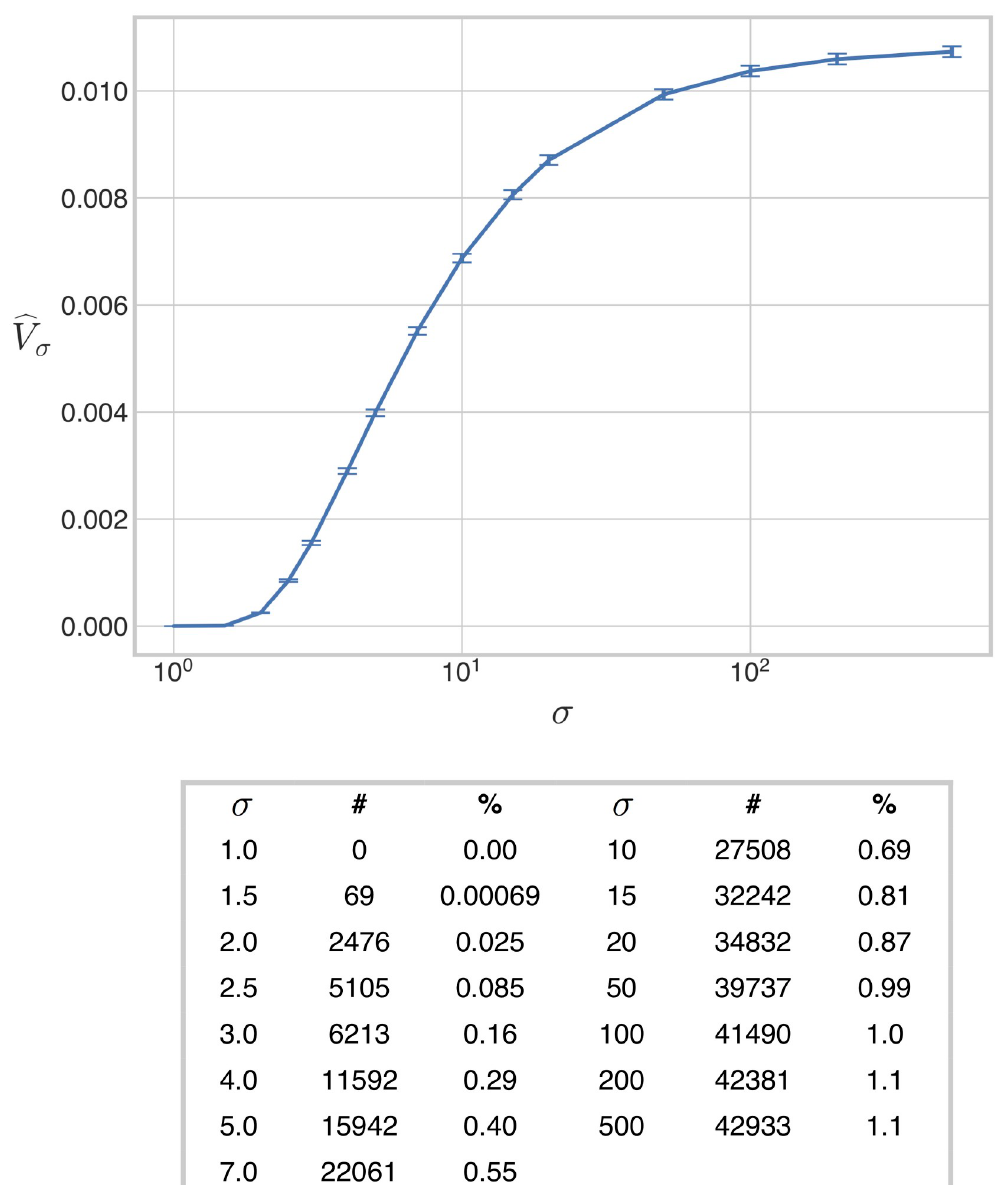
Fig 3. Volume of the bistable region under weak irreversibility. The 8-dimensional volume of the bistable region, normalised as a proportion of the volume of the box H , is plotted against the values of σ in Eq 11, for the case when the reactions S ! E S and S ! F S are weakly irreversible. The accompanying table lists the number of bistable points found for 1 2 1 0 each value of σ , together with the percentage of the box H occupied by the bistable region. The error bars give 95% confidence intervals for each estimate (Materials and methods). The estimates have been joined by line